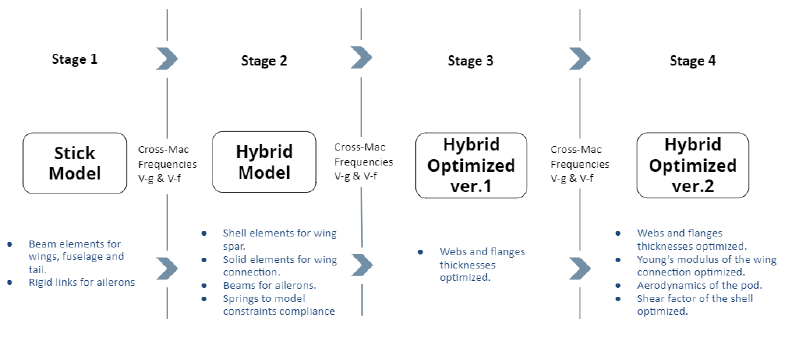
Figure 10. Model evolution during optimization loops with the corresponding characterizing features. Table 5. Design variables trend during optimization.